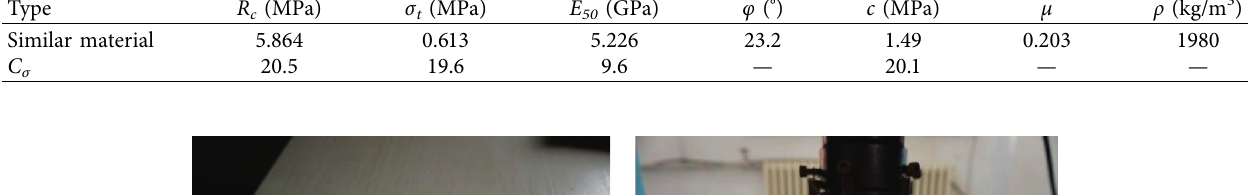
Table 2: Physicomechanical parameters and stress similarity coefficient of the similar materials. Type